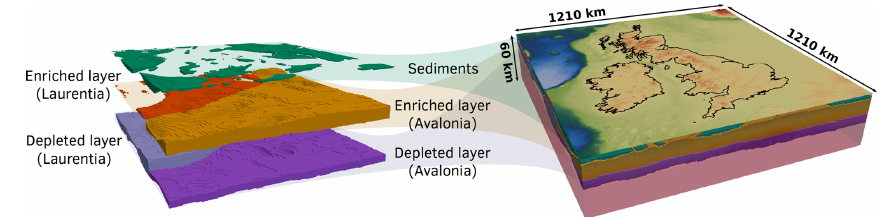
Figure 9. Schematic of each layer in the 3-D thermal model of the British Isles, subdivided from surfaces compiled in Baykiev et al. (2018) (Fig. 8). The model is divided by the Iapetus Suture that separates Laurentian and Avalonian crust. The thickness of the upper (enriched) and lower (depleted) crustal layers is determined by rearranging Eq. (8) for h s and h r , respectively, in Laurentian crust ( H c = 1 . 4µWm − 3 ) and Avalonian crust ( H c = 1 . 2µWm − 3 ).